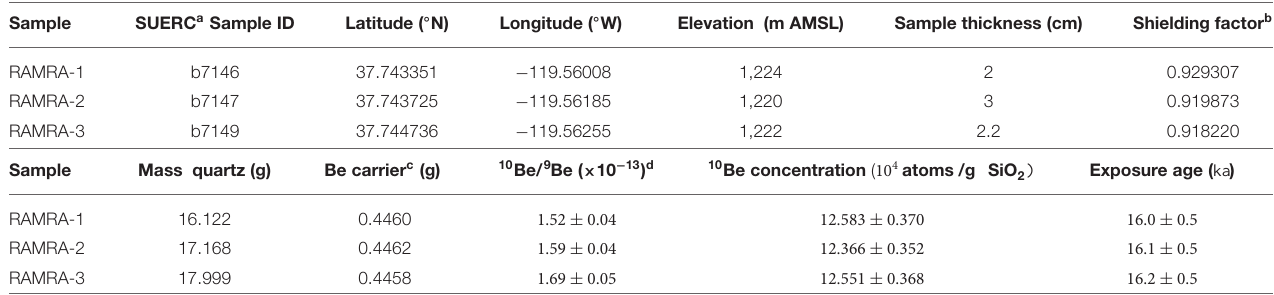
TABLE 1 | Sample data and exposure ages for boulders on the Royal Arches Meadow rock avalanche.